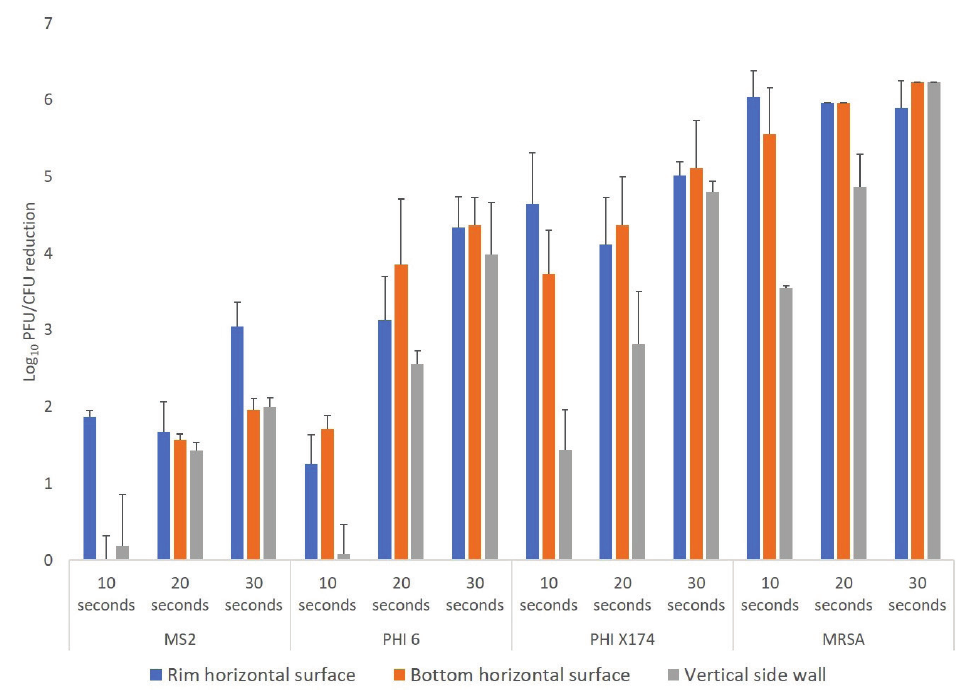
Figure 2 . Efficacy of ultraviolet-C (UV-C) light for decontamination of methicillin-resistant Staphylo- coccus aureus (MRSA), bacteriophage MS2, bacteriophage Phi6, and bacteriophage X174 on plastic bins. Aliquots of 10 μL containing 10 6 colony-forming units (CFU) or plaque-forming units (PFU) of the test organisms in 8% simulated mucus were spread to cover an area of 20 mm on 3 different areas on the